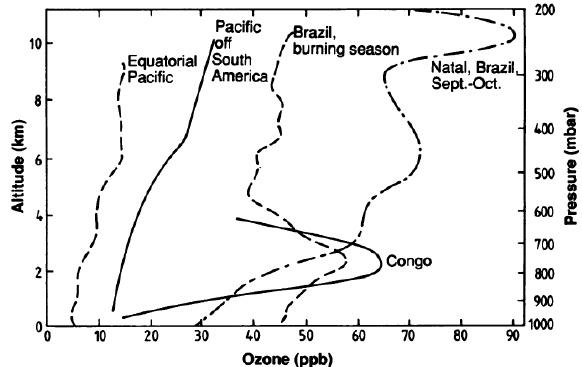
Figure 15. Vertical profiles of O 3 in the tropical troposphere. The profile over the equatorial Pacific shows no influence from biomass burning, whereas the profile over the Pacific off South America sug- gests O 3 enhancement due to long-range transport from the tropical continents. The O 3 profiles over Brazil and the Congo show high O 3 concentrations at altitudes between 1 and 4km due to photochemi- cal production in biomass burning plumes. At higher altitudes, O 3 concentrations are also substantially enhanced, possibly also be- cause of O 3 production by reactions in the emissions of biomass burning (Crutzen and Andreae,